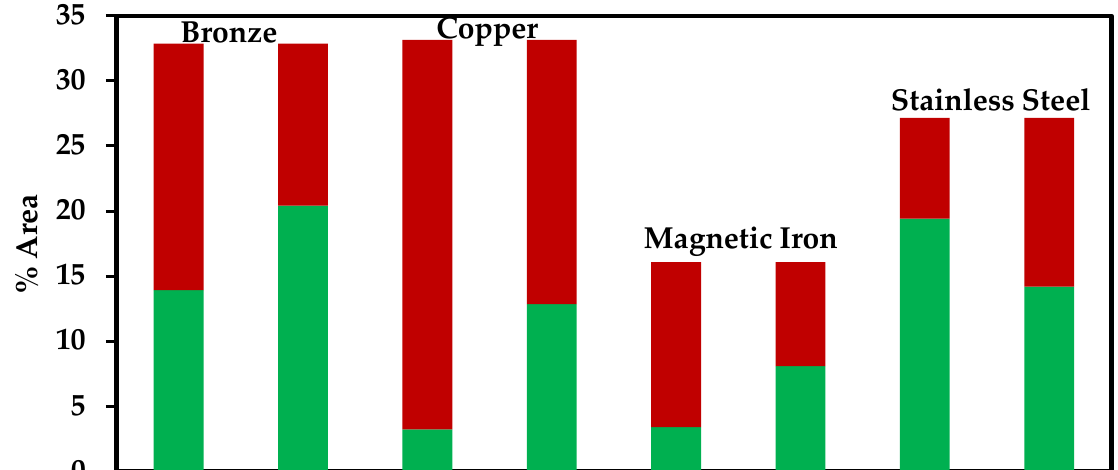
Figure 8. A visualization of the data presented in Table 3 showing the area percentage of total reinforcement observed in filament and printed micrographs.